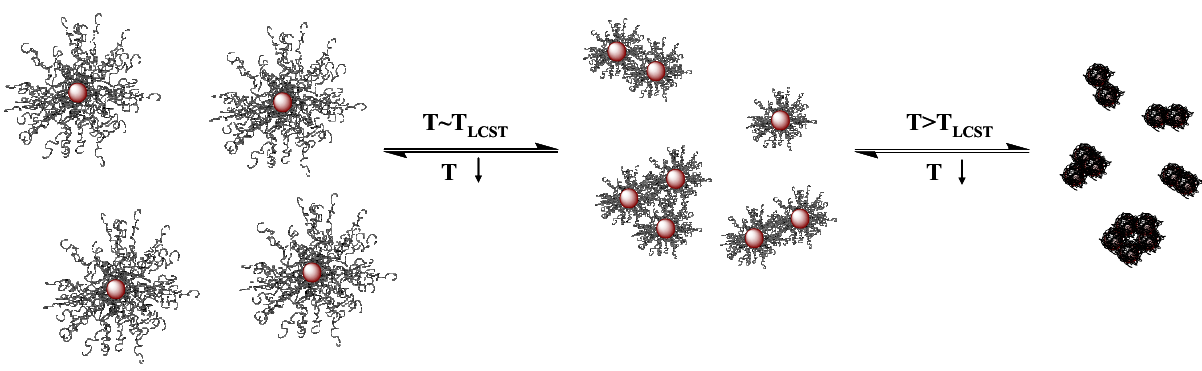
Figure 3. Reversible thermo-induced aggregation of temperature-sensitive